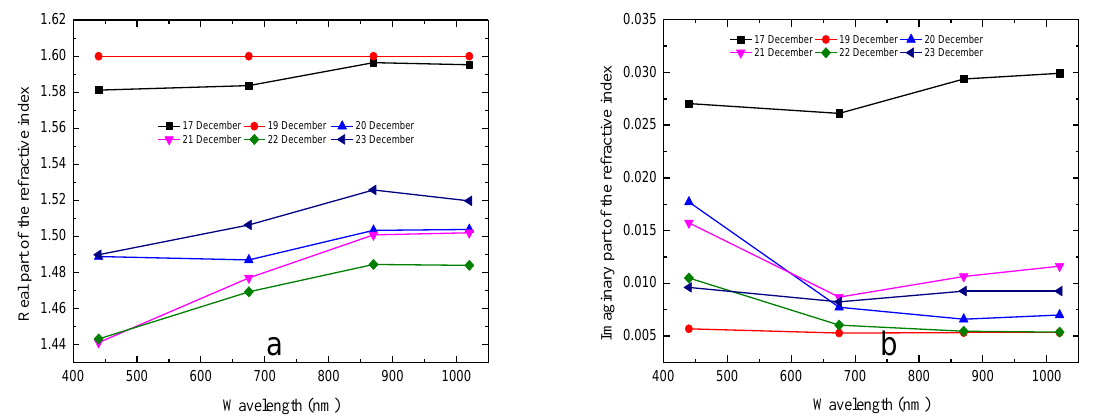
Figure 9. Daily average refractive index during the haze event in Beijing on 17–23 December 2015: ( a ) the real parts; ( b ) the imaginary parts.